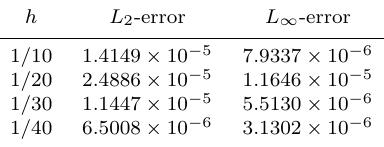
Table 9. Errors for various values of h with γ = 1 and M = N = 5 on the interval [0 , 1] × [0 , 1] for Example 7. h L 2 -error L ∞ -error 1 / 10